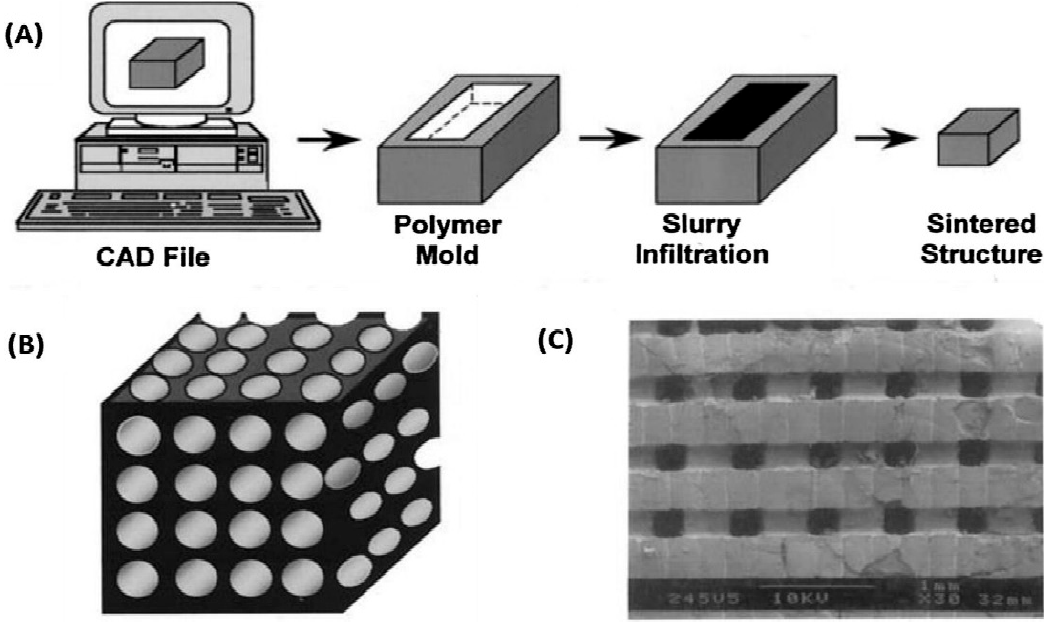
Figure 4. ( A ) Schematic of indirect Fused Deposition Modeling (FDM) processing of ceramic parts ( B ) ( B ) Straight channels ( C ) Top view of sintered porous ceramic part [31]. Materials 2019 , 12 , x FOR PEER REVIEW Straight channels ( C ) Top view of sintered porous ceramic part [31].